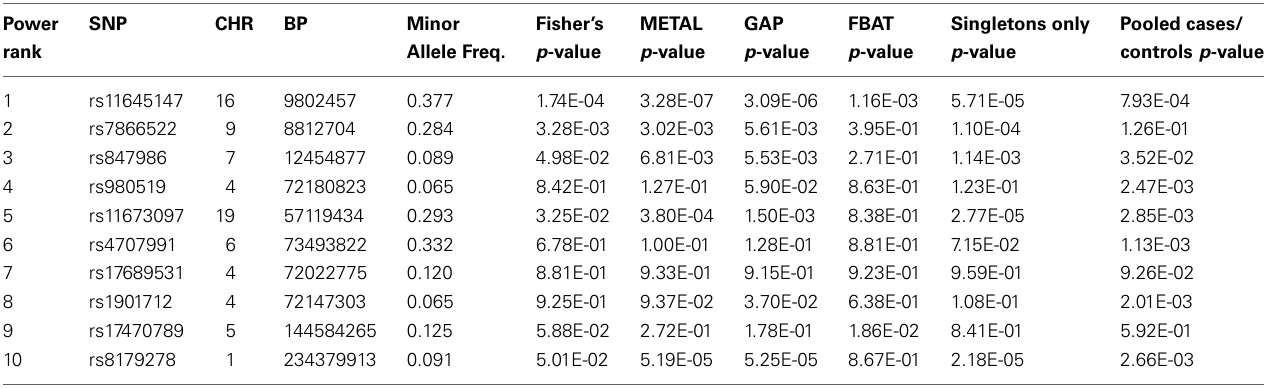
Table 1 | Top ten SNPs by population- and family-based screening